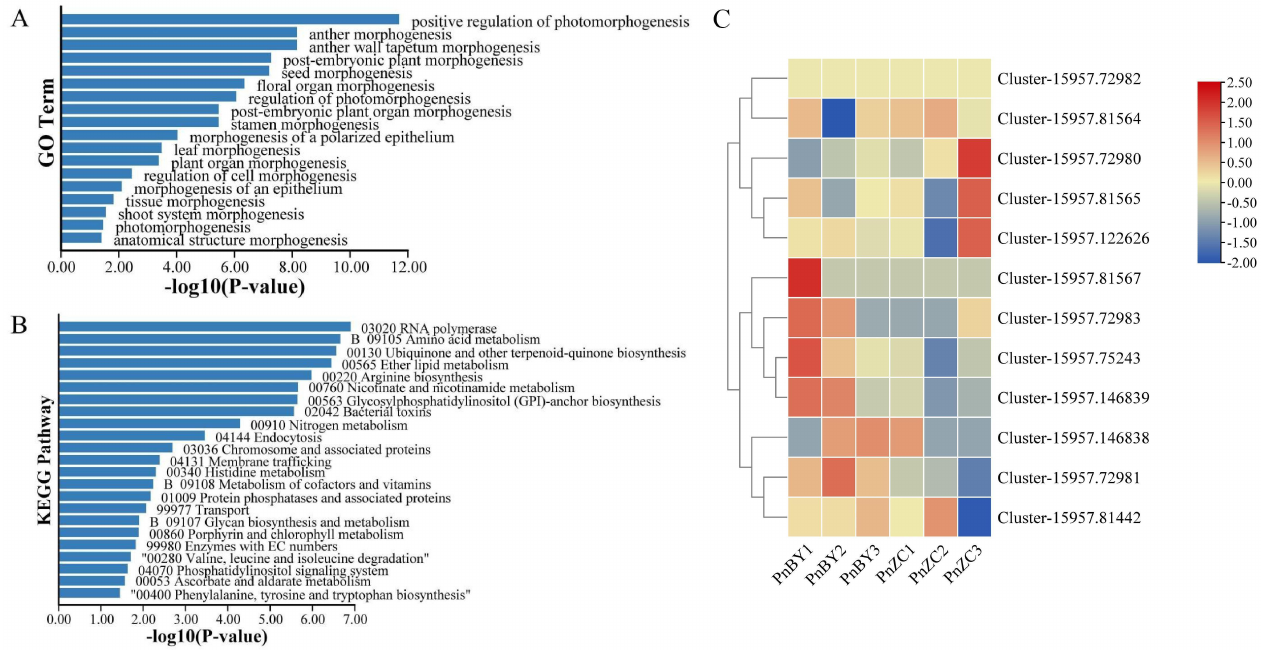
Figure 2. GO, KEGG enrichment analysis, and heat map analysis of target genes. ( A ) GO enrichment analysis of the target genes of differentially expressed miRNAs. Only GO subcategories related to morphogenesis are listed in the figure. ( B ) KEGG enrichment analysis of the target genes. ( C ) Heat map analysis of the target gene of